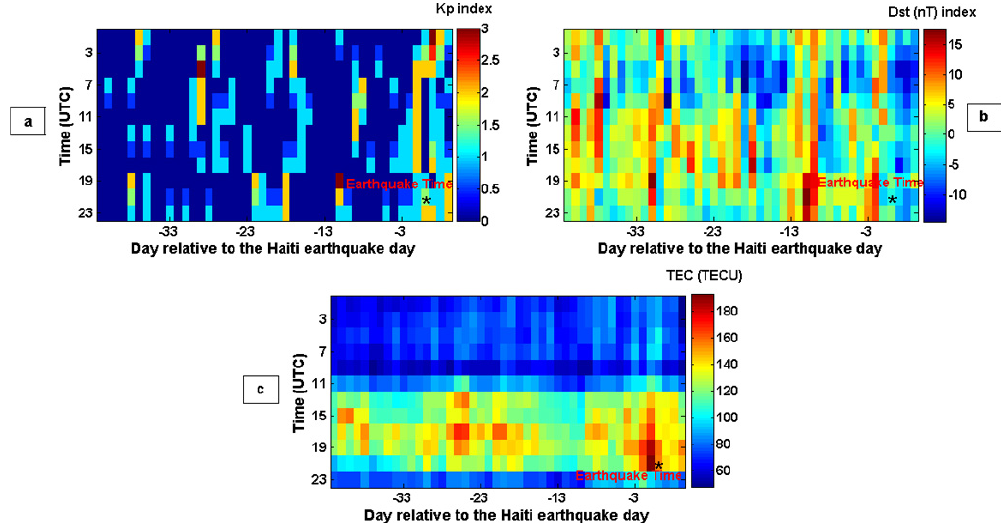
Fig. 5. Data of the Haiti earthquake showing variations of (a) Kp geomagnetic index, (b) Dst geomagnetic index and (c) TEC.